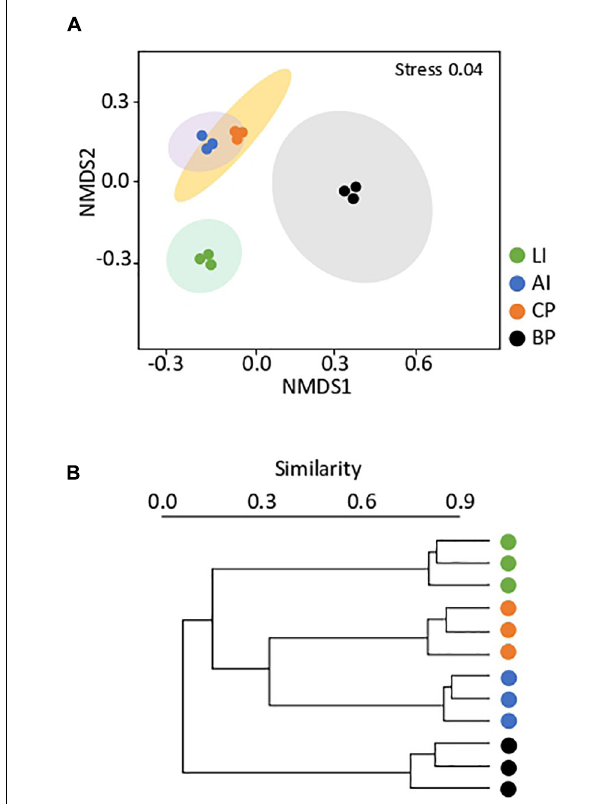
FIGURE 3 | (A) Non-metric multidimensional scaling (NMDS) of the bacterial community composition of Lagotellerie Island (LI), Avian Island (AI), Caleta Primavera (CP), and Byers Peninsula Plateau (BP) microbial mats. The multivariate analysis is based on Bray–Curtis dissimilarity matrices between the microbiome profiles at an ASV level. Distances between symbols on the ordination plot reflect relative dissimilarities in community structures. Ellipses indicate 95% confidence intervals fitted into the spatial ordination. (B) UPGMA cluster dendrogram of the bacterial community within the microbial mats included in this study. The relative abundances were used to evaluate the relationships between bacterial communities, using weighted pair clustering based on Bray–Curtis